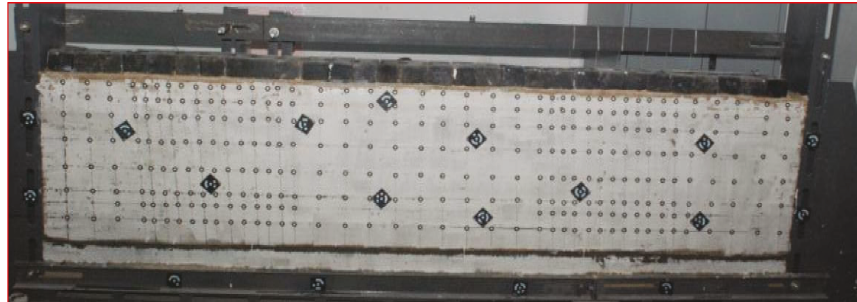
Figure 1: Photo of similar-material model.